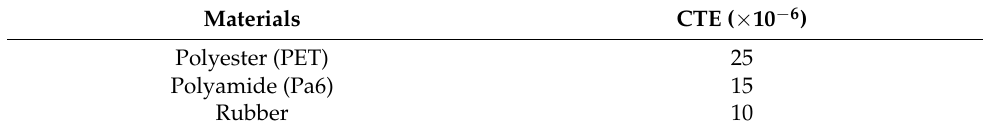
Table 3. Coefficients of thermal expansion (CTE) of the assembly constitutive